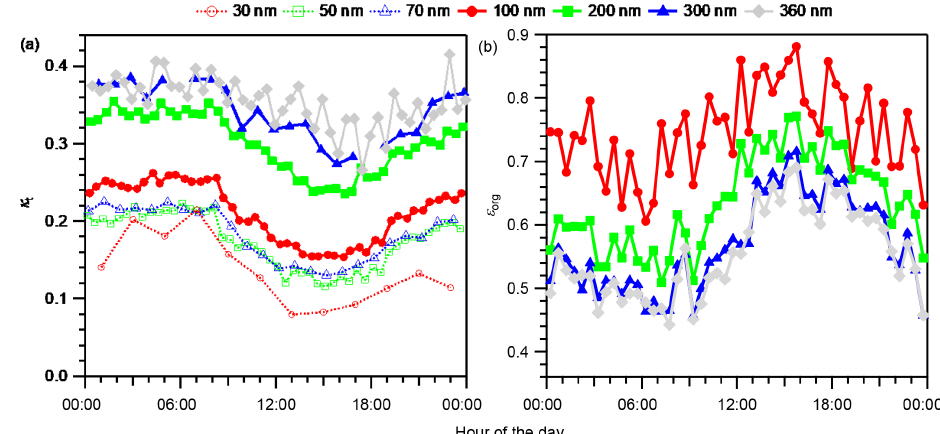
Figure 3. Diurnal variations in (a) size-resolved hygroscopicity of aerosols ( κ t ) and (b) size-resolved volume fractions of OA ( ε org ) for the entire study period. Note that for particles with d dry of 30nm, κ t is presented in 2h time resolution because of the low data coverage (Fig. S12).